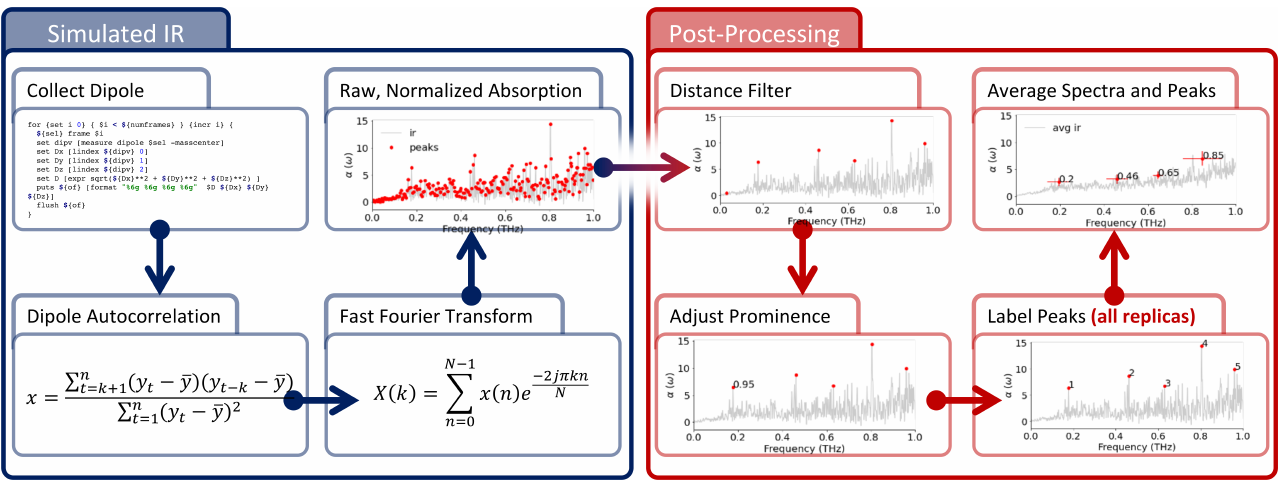
Figure 2. Spectra Calculation and Signal Analysis. Infrared spectra are computed from MD trajec- tories (blue panel) and, then, post-processed to find local maxima. Spectra are computed from MD trajectories as Fourier transform of the membrane total dipole autocorrelation; then, the spectra are normalized before peaks are identified using a distance and prominence filter (Figures S1–S4). For more details, see Section